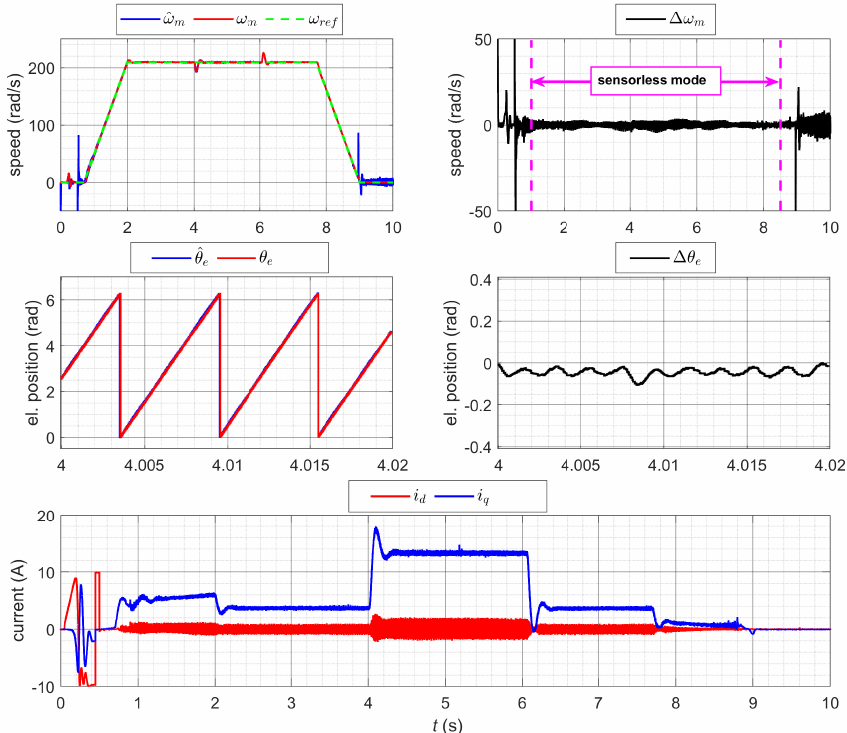
Figure 5. Experimental results for speed and position estimation with sigmoid function, α =